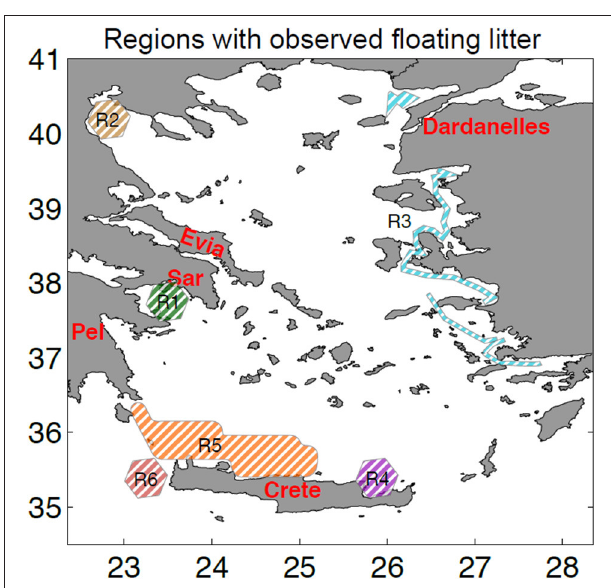
FIGURE 14 | Subregions of sampled floating litter in the Aegean Sea; R1: Saronikos Gulf (Valavanidis and Vlachogianni, 2012; MERMAID Report, 2016), R2: Thermaikos Gulf (Valavanidis and Vlachogianni, 2012), R3: Eastern Aegean Sea (Topcu et al., 2010), R4: Crete island (Cózar et al., 2015), R5: Southwest Aegean Sea ( Kornilios et al., 1998), and R6: Crete island (Cózar et al., 2015).